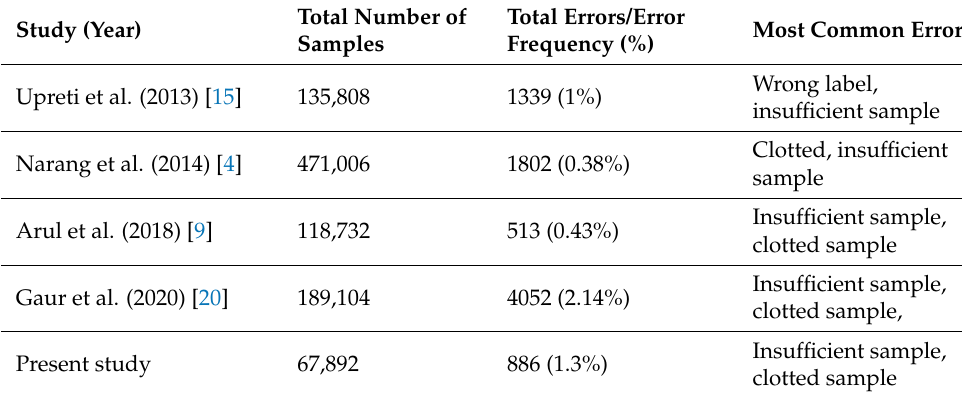
Table 4. Comparison of preanalytical errors in hematology